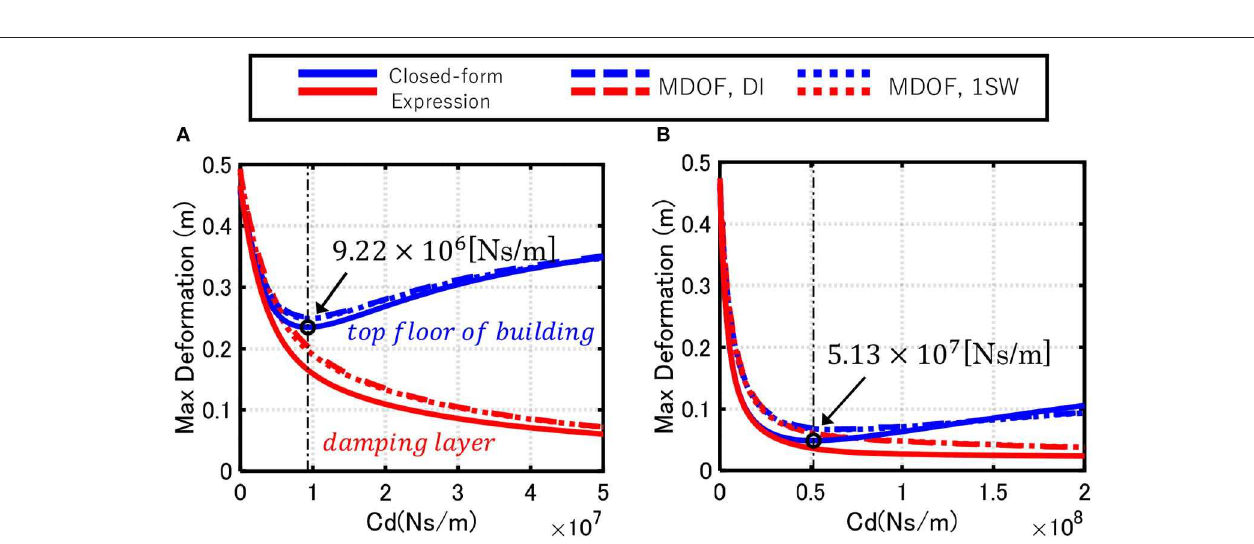
Frontiers in Built Environment |